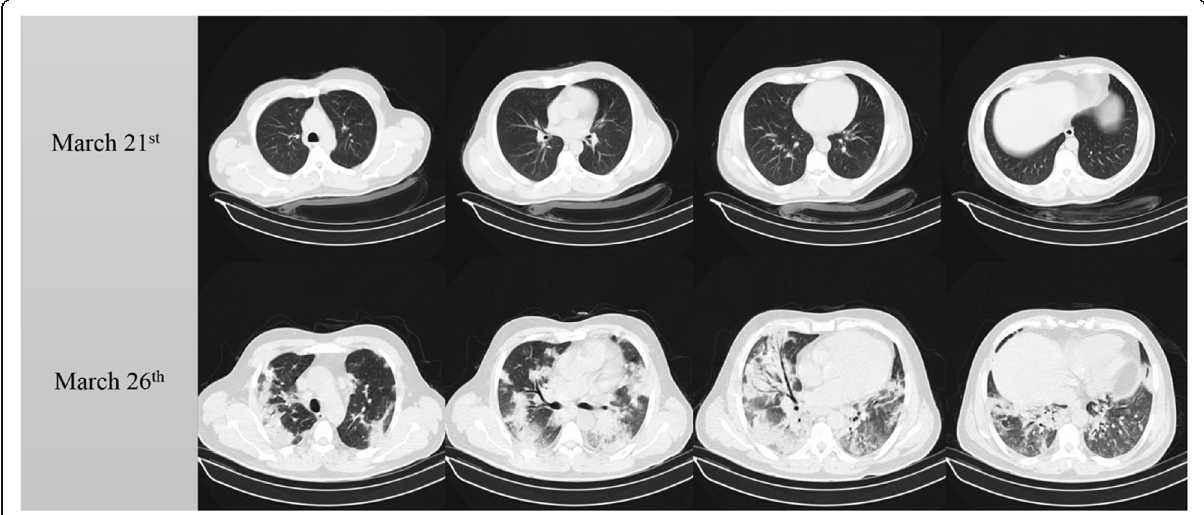
Fig. 2 The first row is the chest CT which is obtained at the first presentation of the patient to the emergency ward, and the second row is the chest CT which is obtained days after. As it is obvious, the first CT scan shows the normal appearance, and the following one shows multiple bilateral ground-glass opacities with airspace consolidation and some degree of bronchiectasis in the lower